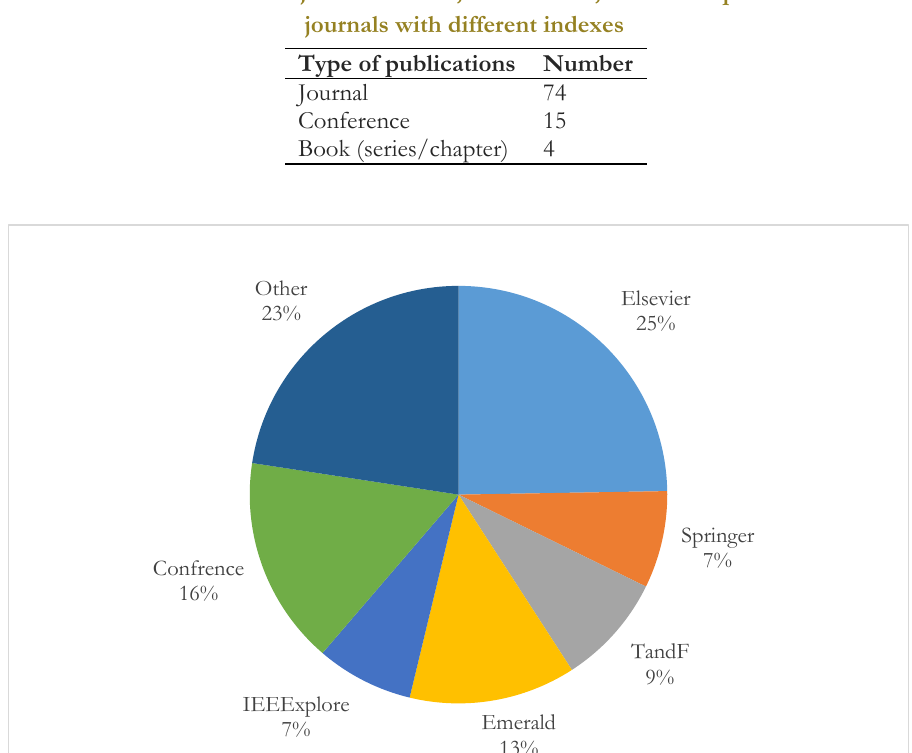
Table 2. Number of journal articles, conferences, and books published in journals with different indexes